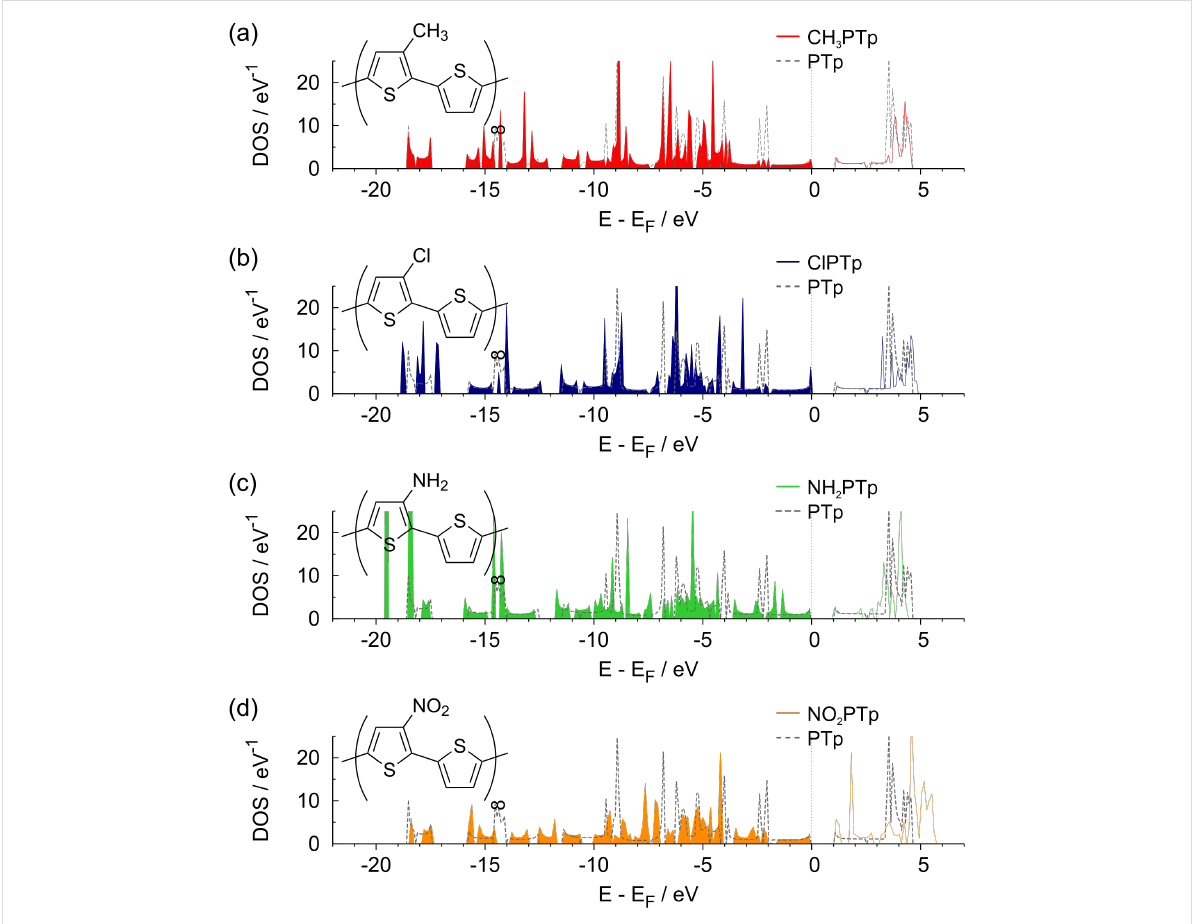
Figure 5: Density of states of substituted polymers: (a) CH 3 PTp, (b) ClPTp, (c) NH 2 PTp and (d) NO 2 PTp. As a comparison, in each panel the DOS of the unsubstituted PTp is indicated by the dashed lines.